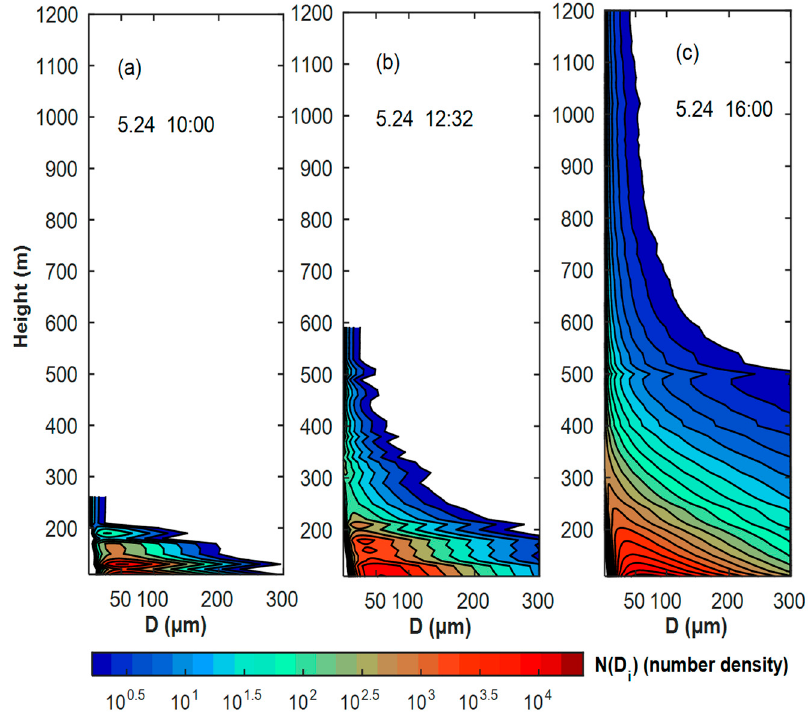
Figure 8. The altitudinal distribution of the dust spectrum distribution. ( a ) The floating dust at 10:00, ( b ) the blowing sand—12:32 and ( c ) the dust storm at 16:00.